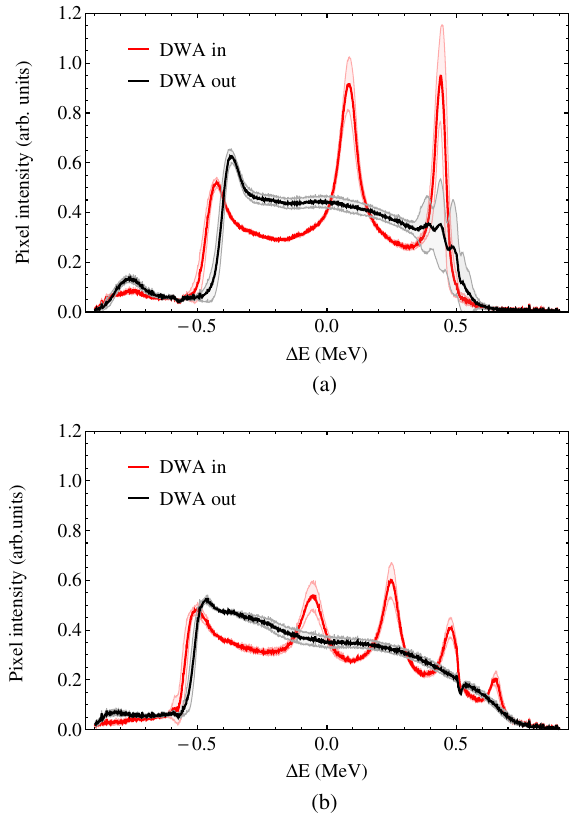
FIG. 42. Energy modulation imposed on the beam energy spectrum with DLW structure (red line) and without (black line) at two linac off-crest phases: − 15 ° (a) and − 22 ° (b), respectively.